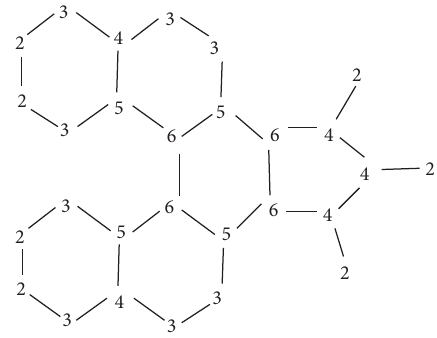
Figure 7: D [ 1 ] along with the CN of each vertex. 2